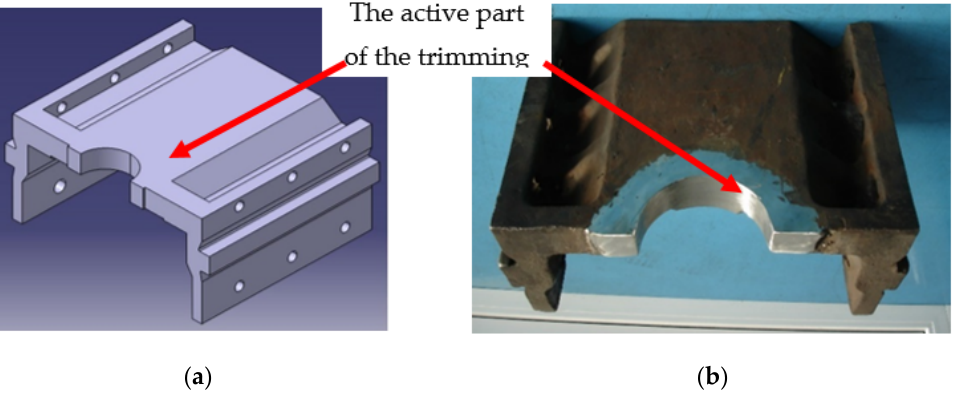
Table 2. The physical properties of the steel used to make the trimming dies X210Cr12 [20]. Figure 3. Presentation of the trimming dies used in the cleaning operation: ( a )—cleaning trimming die—3D representation; ( b )—image of the real trimming die used for cleaning.